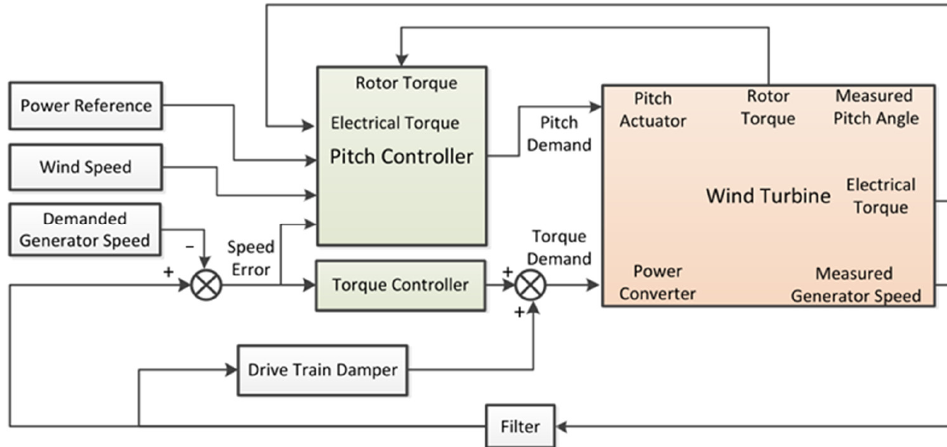
Figure 2. Wind turbine main controller and filter circuit.